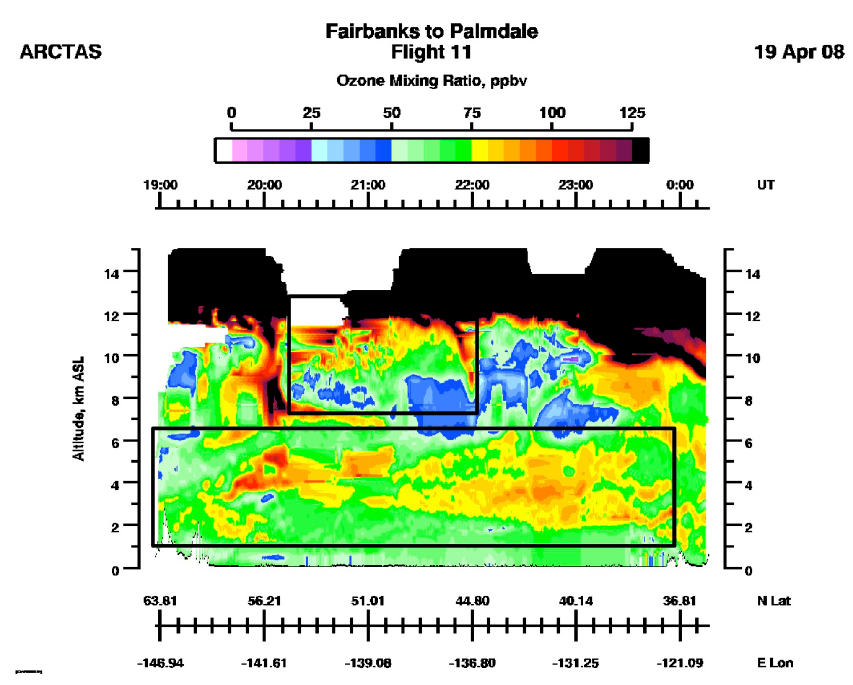
Fig. 5. Differential Analysis Lidar ozone (O 3 ) mixing ratio. The rectangles indicate the two ozone Figure 5: Differential Analysis Lidar ozone (O two ozone plumes